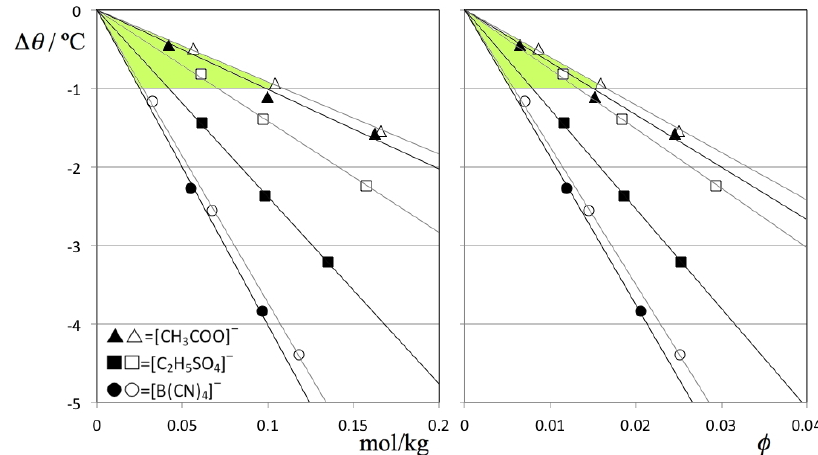
Figure 5. TMD shifts,  , as a function of (A) molal concentration and (B) solute volume fraction,  , for D O (filled symbols) and H V 2 mim][CH COO] = (triangles); [C ionic liquids: [C 2 3 [C mim][B(CN) ] = circles. The shaded areas highlight a narrower range of slopes for 2 4